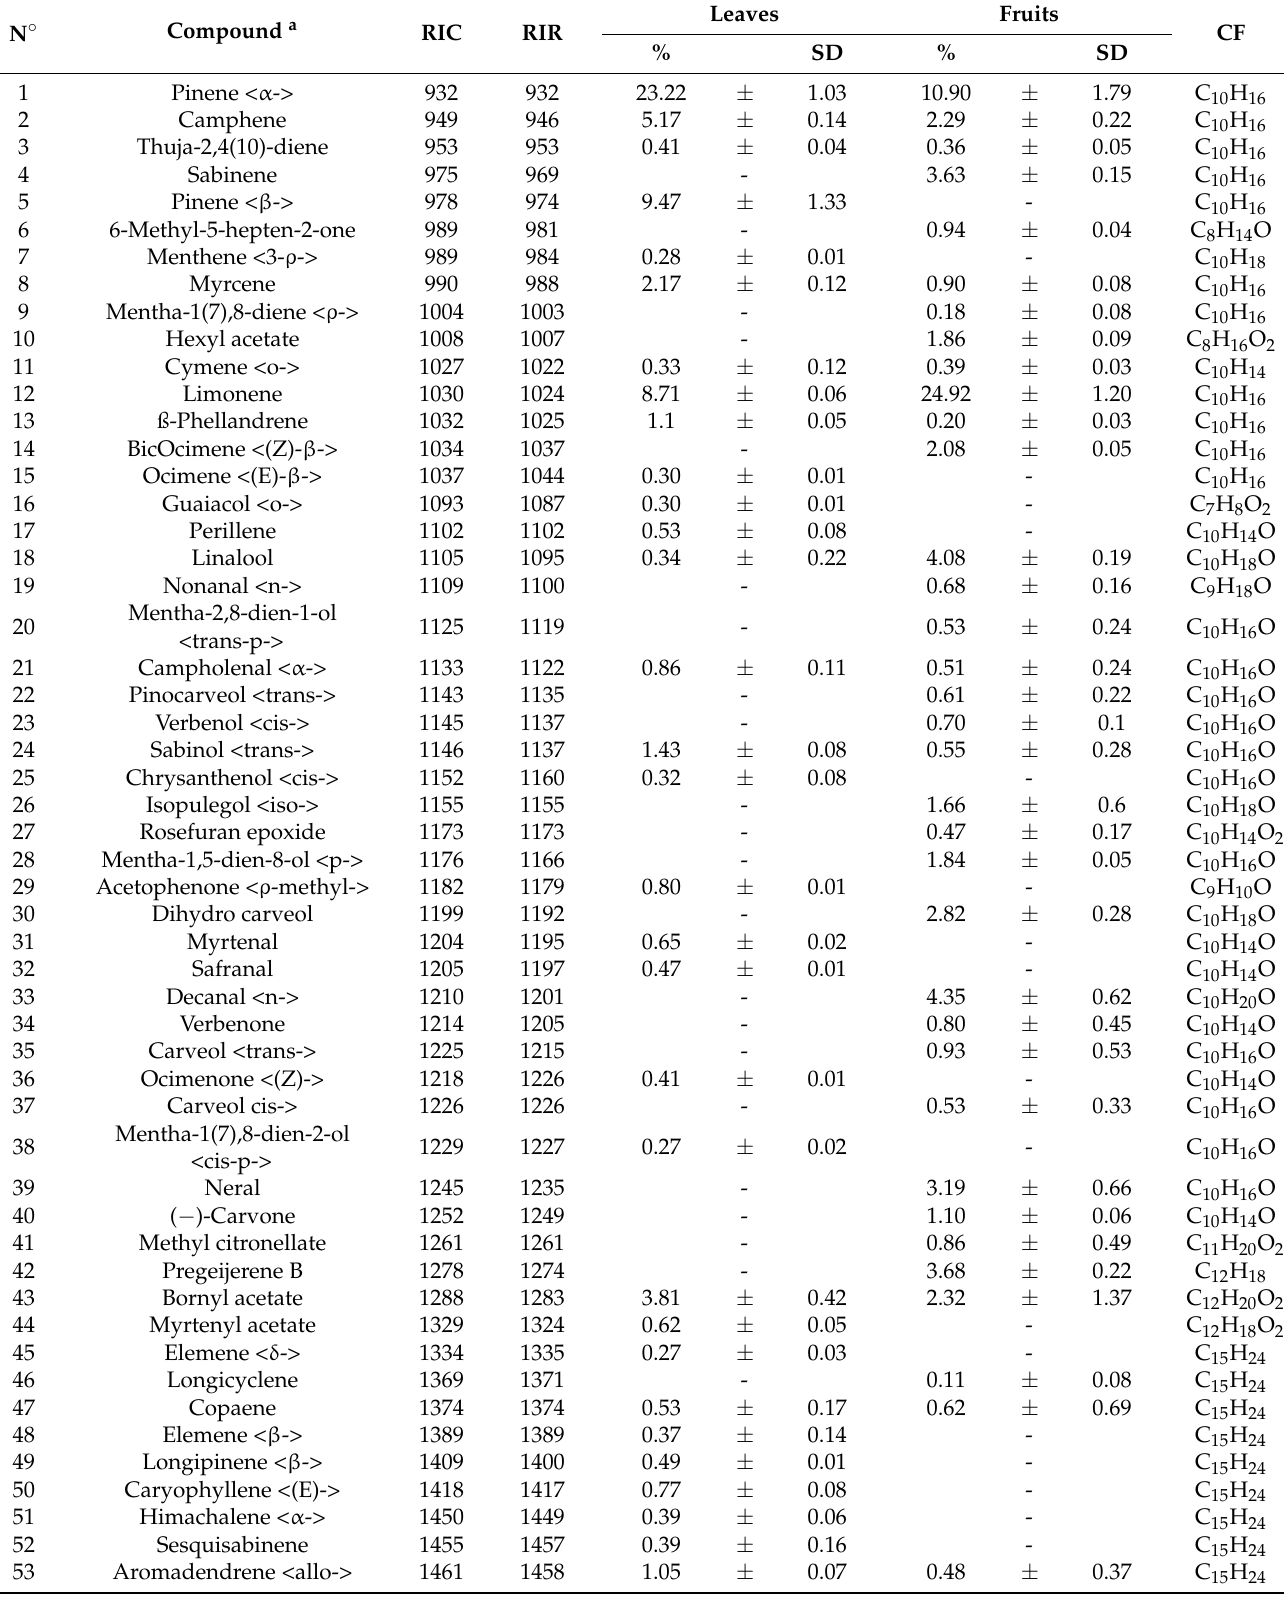
Table 1. Chemical composition of essential oil from the leaves and fruits of Siparuna muricata